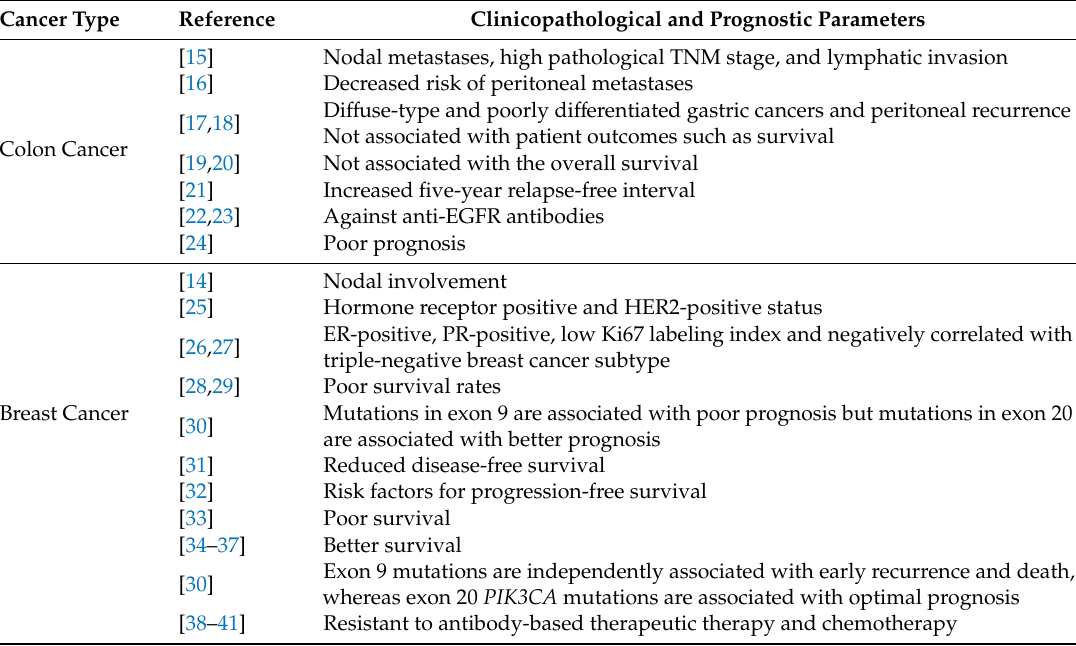
Table 1. Association of PIK3CA mutation with clino-pathological and prognostic